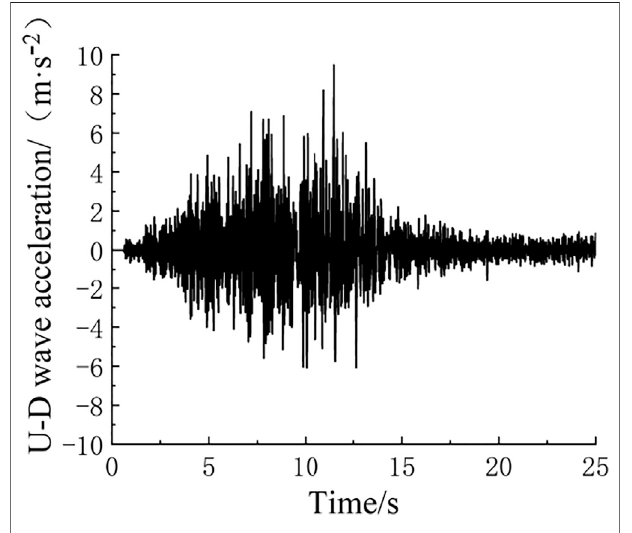
FIGURE 3 | Longitudinal U-D wave curve of the 2008 Wolong Wenchuan earthquake.